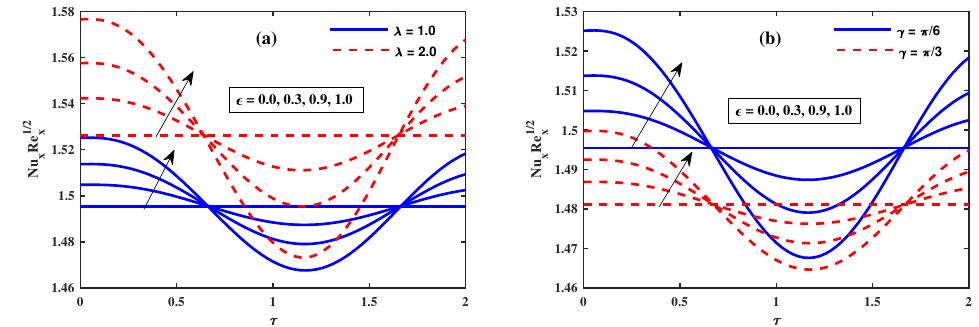
Figure 12. Fluctuation of Nu x Re 1/2 x against (cid:101) (amplitude), ( a ) λ (mixed convection parameter), and ( b ) γ (inclined